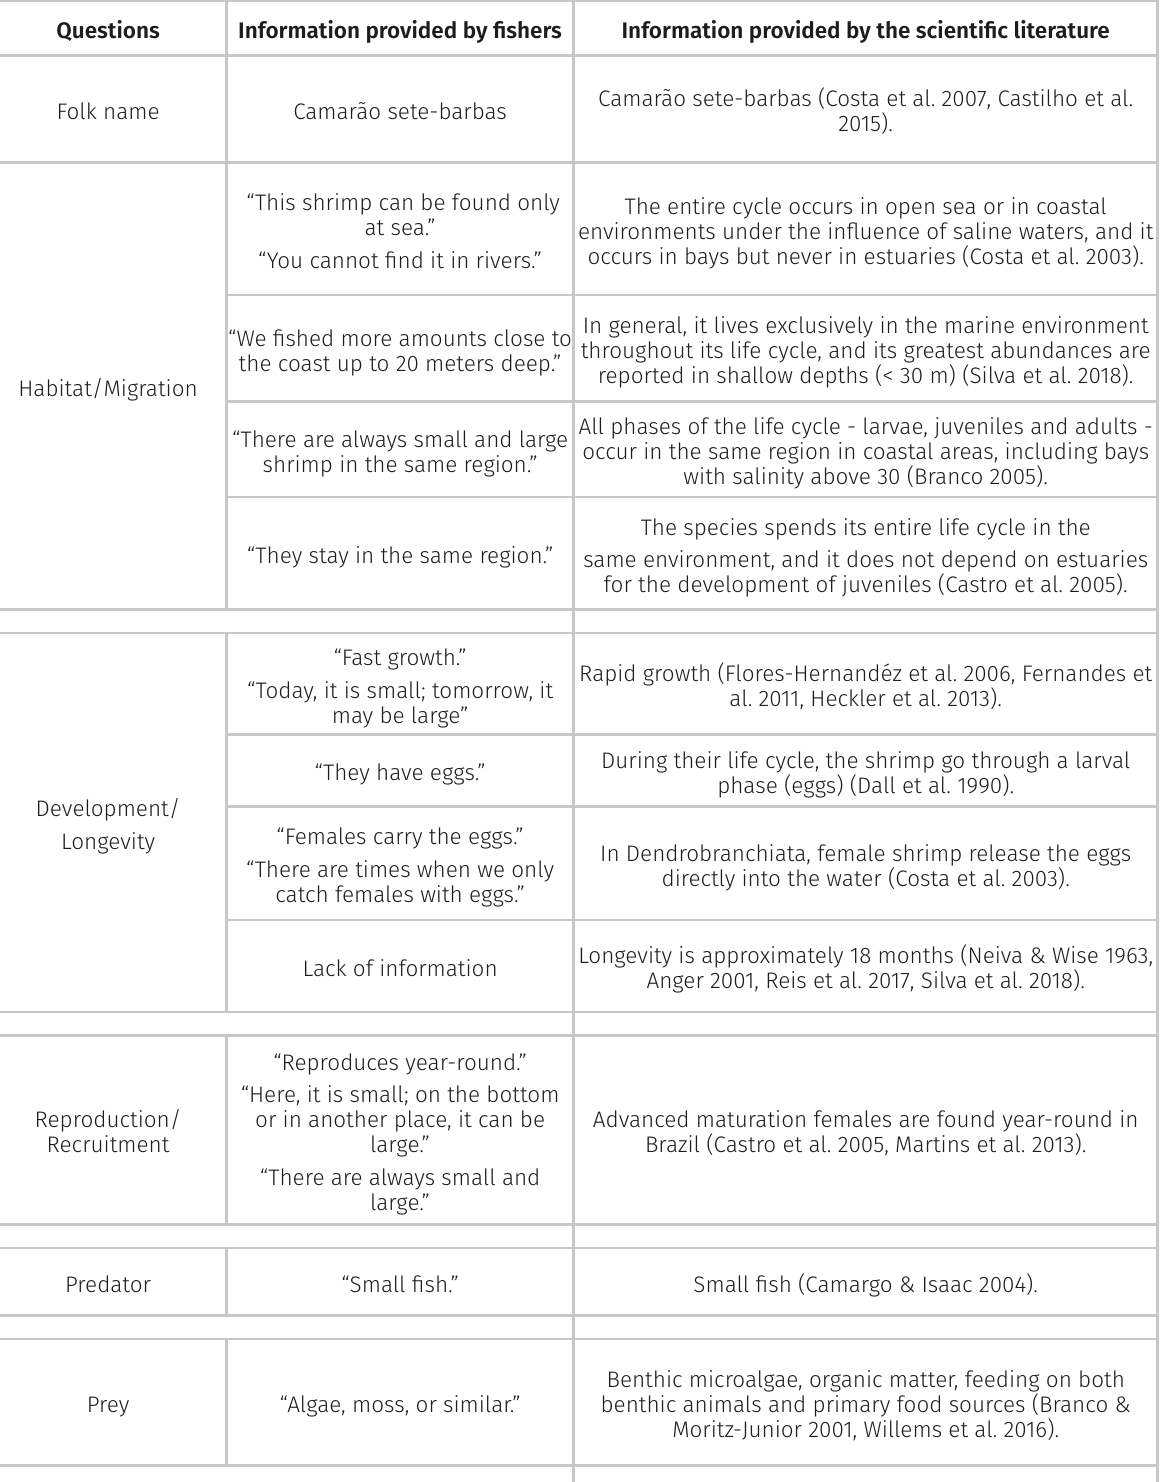
Table II. Cognitive matrix comparing information among the local ecological knowledge of the fishers and the literature on the biology and ecology of the X. kroyeri